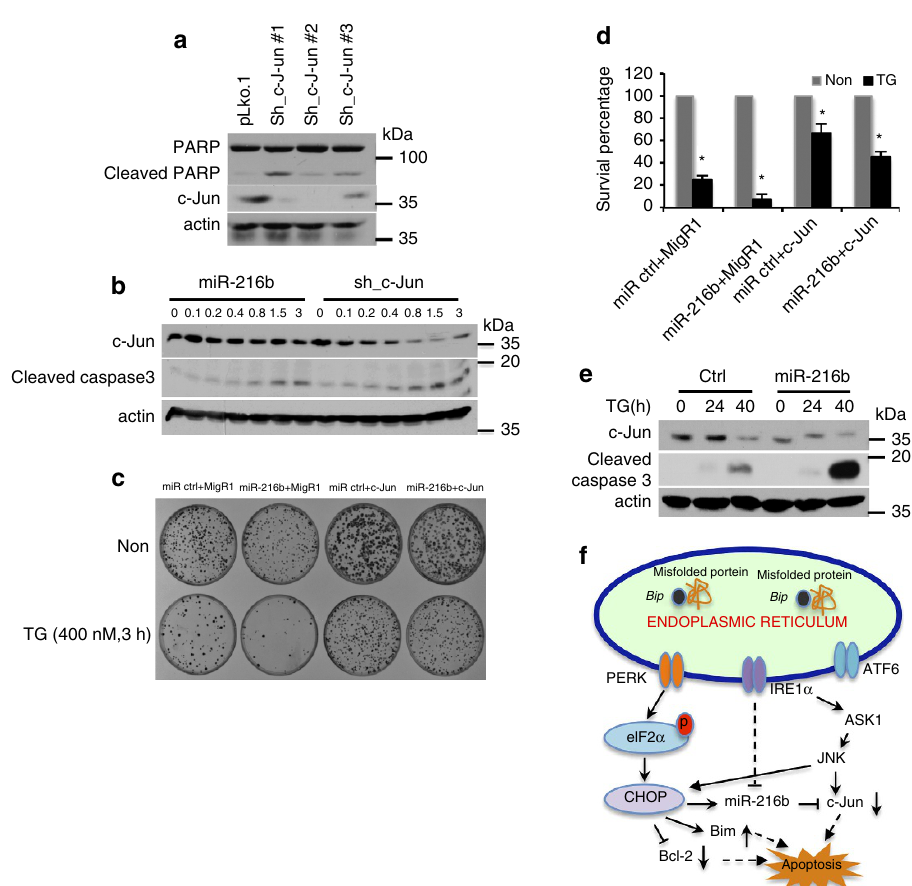
Figure 7 | MiR-216b sensitizes cells to ER stress-dependent apoptosis via regulation of cJun. ( a ) c-Jun knockdown with three independent shRNA (top panel). Total and cleaved PARP and cJun were assessed by immunoblot (middle panel). ( b ) U2OS cells were infected with virus encoding either miR-216b or sh-c-Jun # 2 (from panel a ) at varying viral concentrations (top). C-Jun and cleaved caspase 3 were quantified by immunoblot 48h post infection. ( c ) U2OS cells stably expressing control, miR-216b or A-miR-216b were infected with retrovirus coding MIGR1 or c-Jun for 3 days, cells were plated at 2 (cid:3) 10 3 cells per 60mm dish, treated with 400nM thapsigargin (TG) for 1–3h, and then returned to growth medium for 12 days. ( d ) Quantification of Giemsa-stained colonies from c . Average cell survival fractions (TG treatment/untreated). Values are means ± s.d. ( n ¼ 3). ( e ) miR-216b was introduced into CHOP (cid:2) / (cid:2) cells, treated as indicated with TG and assessed for accumulation of cleaved caspase 3. ( f ) Model depicting CHOP-dependent regulation of miR-216b and CHOP-dependent apoptosis. Data are mean ± s.d. of three independent experiments. Statistical analysis was analysed by Student’s t -test (* P o